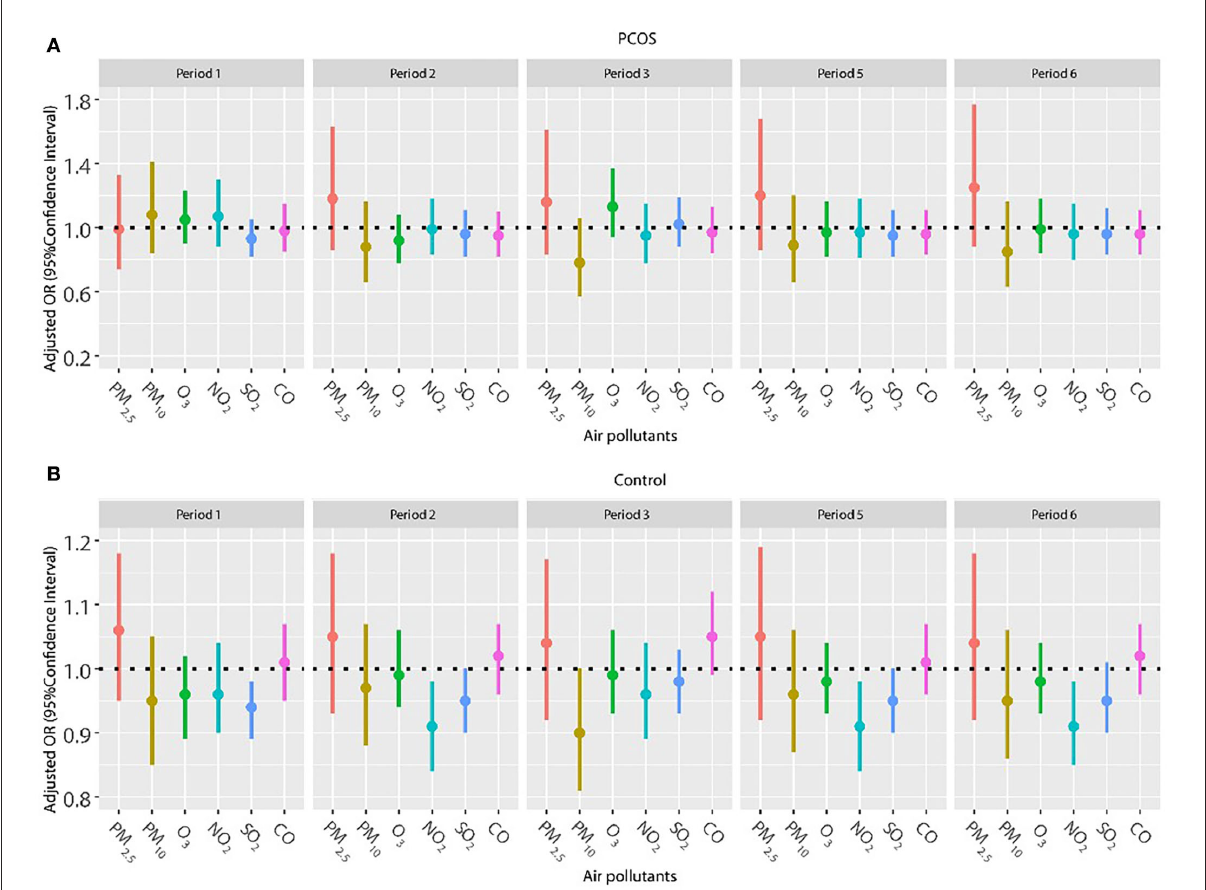
FIGURE4 (A,B) Association between ambient air pollution exposure and clinical pregnancy rate among women with and without PCOS younger than 35 years. Results showed in bold indicated statistically significant associations. PM 2.5 , particulate matter ≤ 2.5 µ m, µ g/m 3 ; PM 10 , particulate matter ≤ 10 µ m, µ g/m 3 ; NO 2 , nitrogen dioxide, µ g/m 3 ; SO 2 , sulfur dioxide, µ g/m 3 ; CO, carbon monoxide, mg/m 3 ; O 3 , ozone, µ g/m 3 . Model adjusted for BMI, education level, infertility type (primary or secondary infertility), infertility duration, infertility cause (female factor, male factor, both, and unexplained factor), type of embryo transfer (fresh or frozen embryo transfer), number of embryos transferred (one or two), fertilization method (IVF, ICSI, or IVF + ICSI), endometrial thickness, and season of embryo transfer (spring, summer, autumn, or winter). Periods 1, 2, 3, 5, and 6 indicate the exposure windows shown in Figure